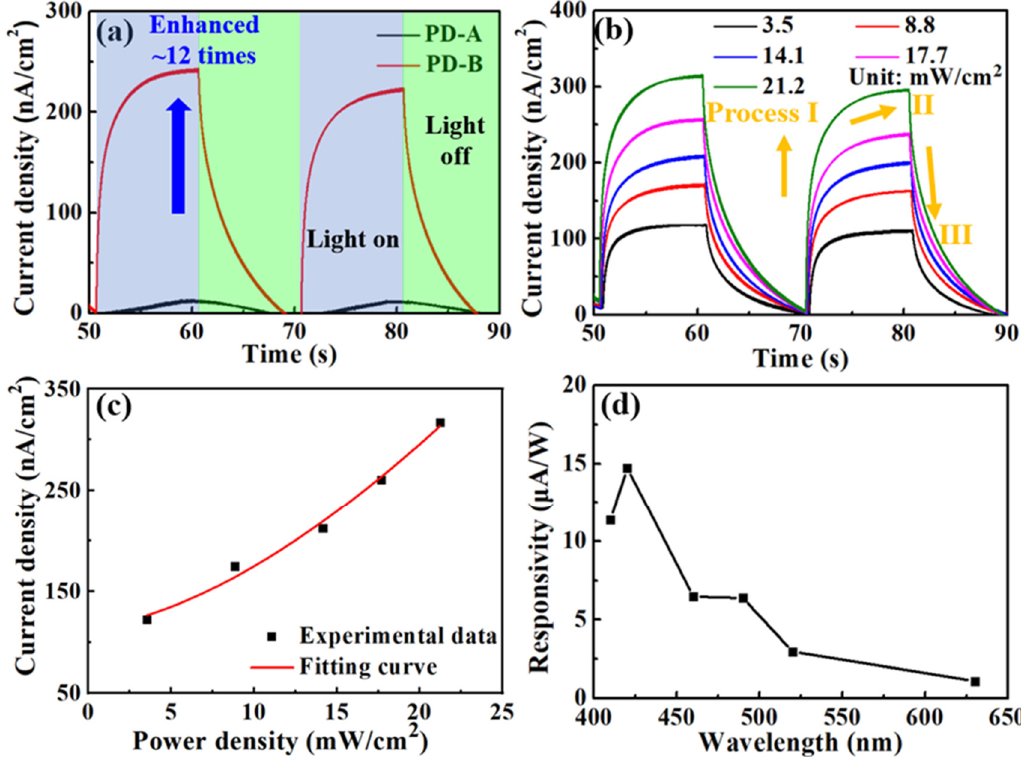
Figure 4. ( a ) Photo-switching behaviors of the self-powered PDs under 420 nm illuminations; ( b ) photocurrent densities of PD-B illuminations with different light powers. The unit of incident light power density is mW/cm 2 ; ( c ) photocurrent density as a function of power density at 420 nm; ( d ) responsivity of PD-B at different wavelengths of illumination light.